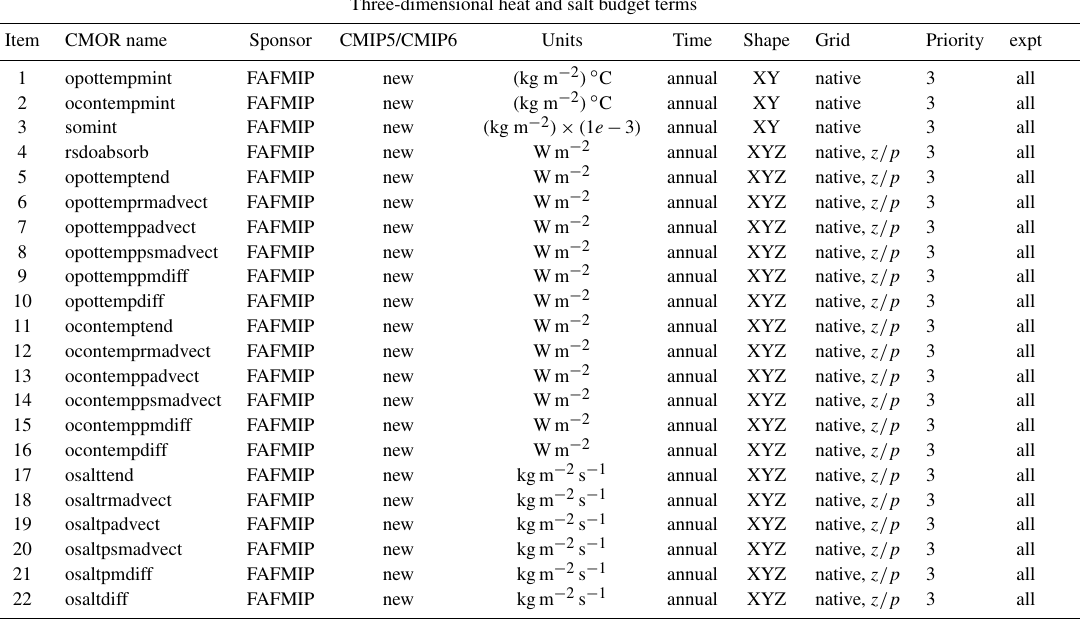
Table L1. This table summarizes fields that support the study of three-dimensional ocean heat and salt budgets, listing here terms contributing to the time tendency of heat and salt in a model grid cell, mass and thickness of a cell, and depth-integrated heat and salt. Annual means fields are Priority = 1 for the FAFMIP experiment (Gregory et al., 2016), whereas the monthly means are Priority = 2. For all other experiments, the annual means are Priority = 3, as listed here. For models with prognostic temperature given by potential temperature, then these models should fill the potential_temperature fields and leave the conservative_temperature fields blank; conversely for models with Conservative Temperature as the prognostic temperature field. The column indicating the experiment for saving the diagnostics generally says “all”, in which case we recommend the diagnostic be saved for CMIP6 experiments in which there is an ocean model component, including the DECK, historical simulations, FAFMIP, DAMIP, DCPP, ScenarioMIP, and C4MIP, as well as the ocean/sea-ice OMIP simulations. The lower sub-table lists the CMOR names and the corresponding CF standard